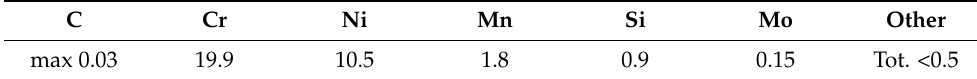
Table 1. Chemical composition of AISI 308LSi welding wire.